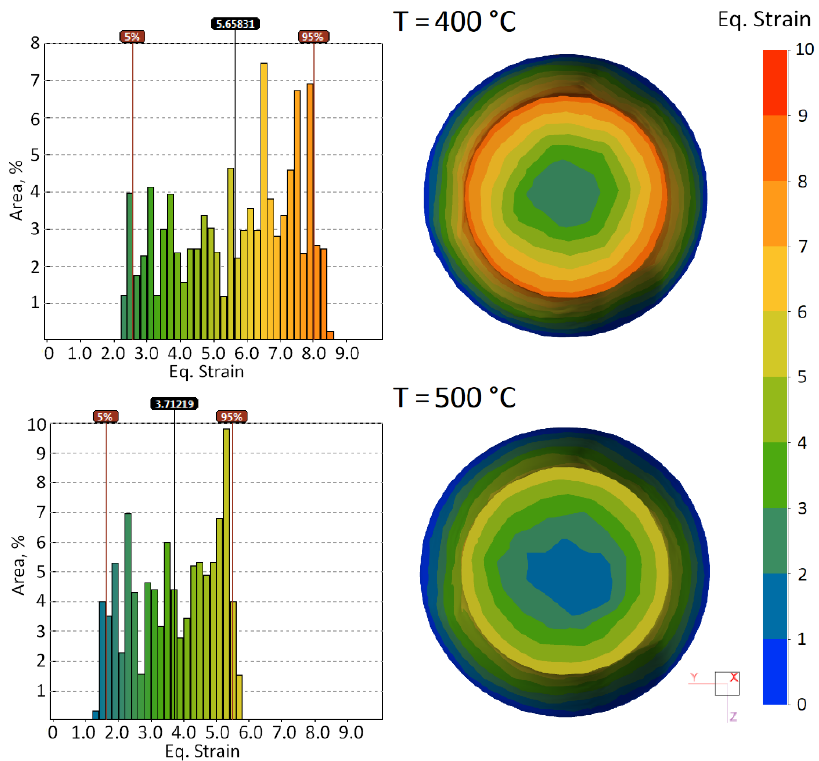
Figure 6. The field of equivalent strain distribution in cross section of the bar for different temperatures.